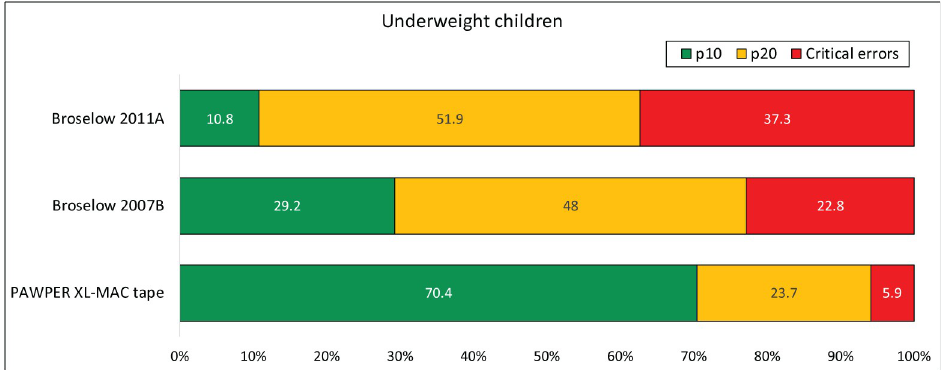
Fig 5. Accuracy of the three systems in underweight children. The chart shows the proportion of weight estimations falling within 10% and 20% of actual weight (p10 and p20 respectively) as well as the proportion of critical weight estimation errors ( > 20% error) for children with a BMI-for-age Z-score less than -1.4. This subgroup data was not available for the Ralston method as it information was not presented in the original publication. The McNemar test was significant at the p < 0.001 level for every comparison of p10 and p20. The PAWPER XL-MAC method p10 and p20 were clinically superior to both versions of the Broselow tape and the Broselow 2007B was clinically superior to the Broselow